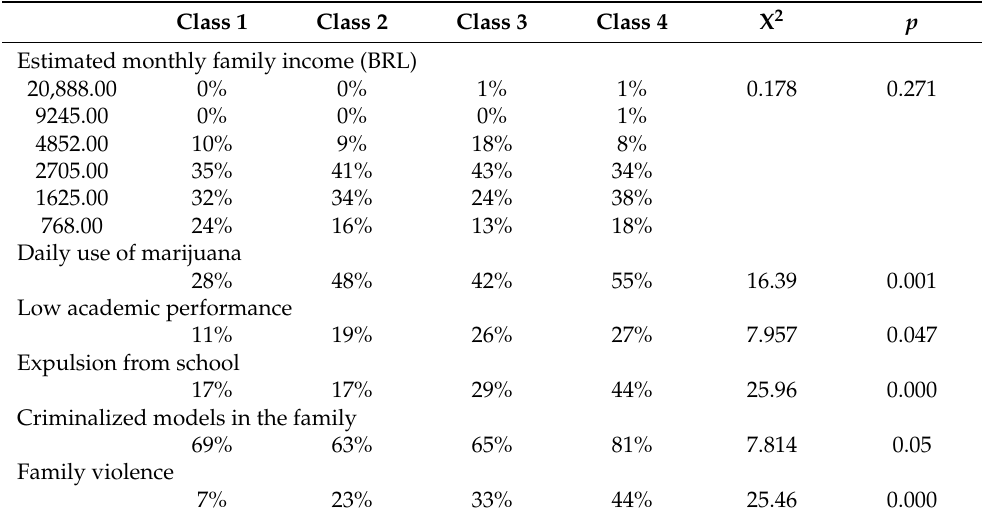
Table 1. Characterization of the classes in relation to the categorical variables and to the chi-square